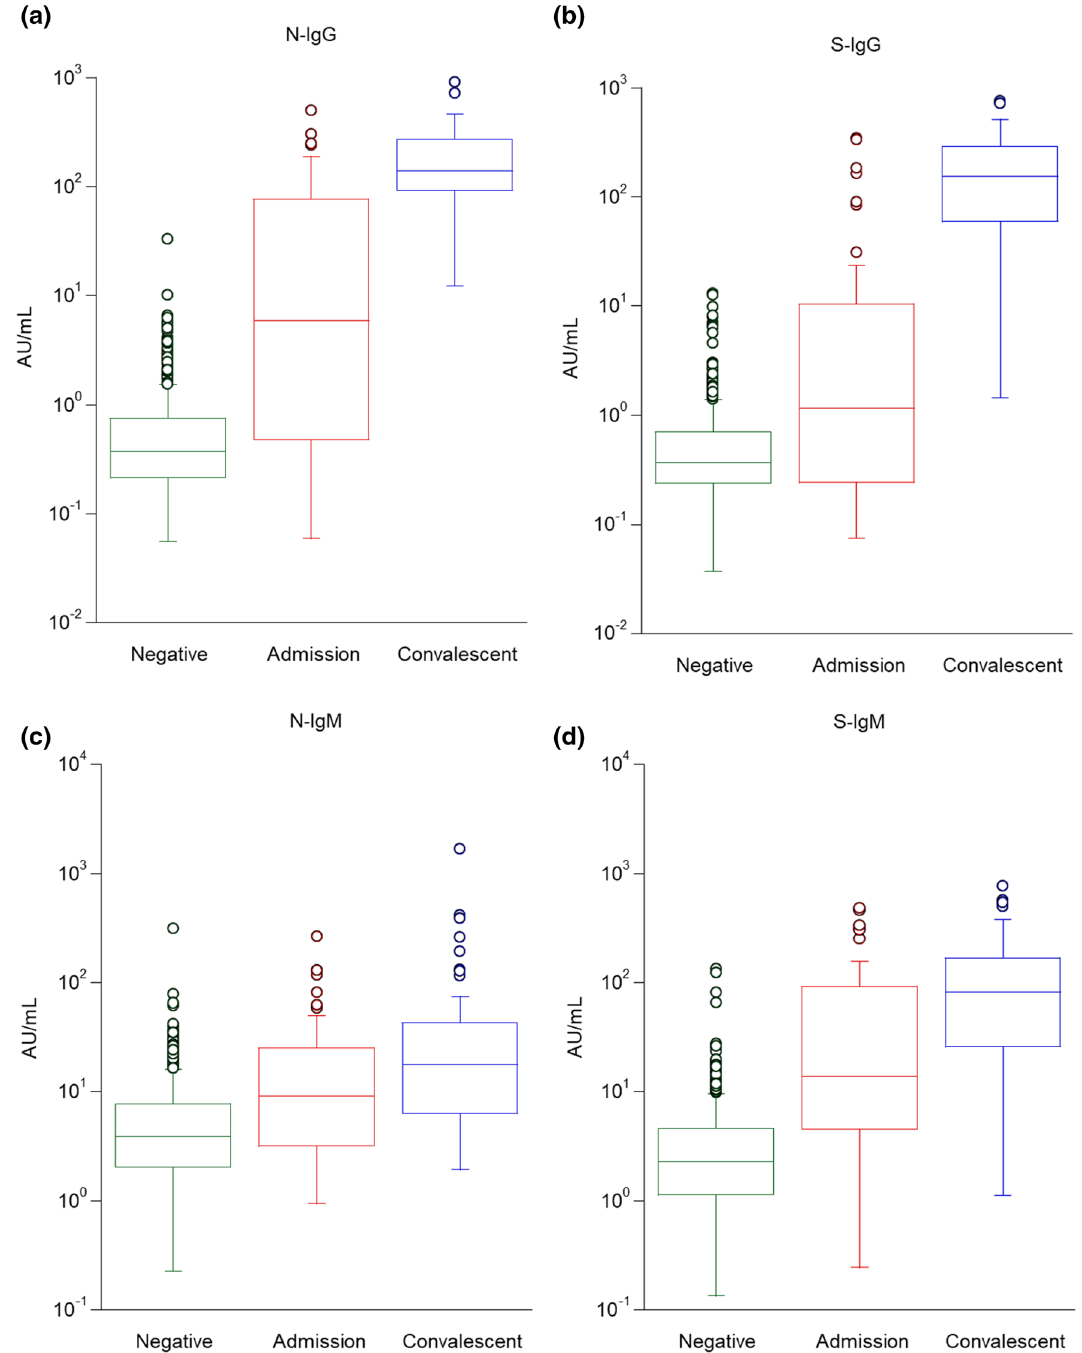
Figure 3. Relationship between antibody levels at negative, admission, and convalescent patients. A total of 500 negative samples, 50 admission samples, and 60 convalescent samples were analyzed using each antibody detection reagent. N-IgG ( a ), S-IgG ( b ), N-IgM ( c ), and S-IgM ( d )